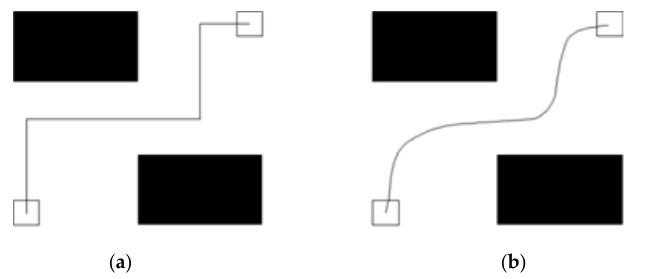
Figure 5. ( a ) Path created by global planner and ( b ) elastic band after optimization.